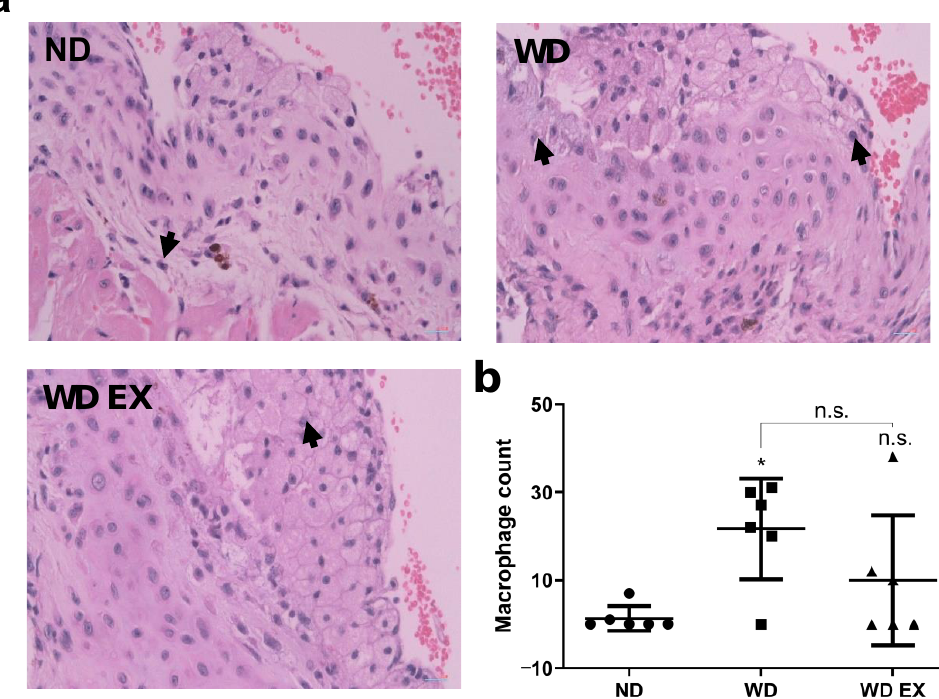
Figure 5. Effects of exercise on ( a ) macrophage infiltration in cholesterol plaque, the black arrows mean the macrophage infiltrated in the plaque and ( b ) quantitative analysis of macrophage count in plaque in ApoE knockout mice. The results are expressed as means ± standard deviation ( n = 6). One-way ANOVA followed by Tukey’s post hoc test was used for statistical analysis, and * p < 0.05 represents the significance between ND and WD groups. n.s. = No significant difference.